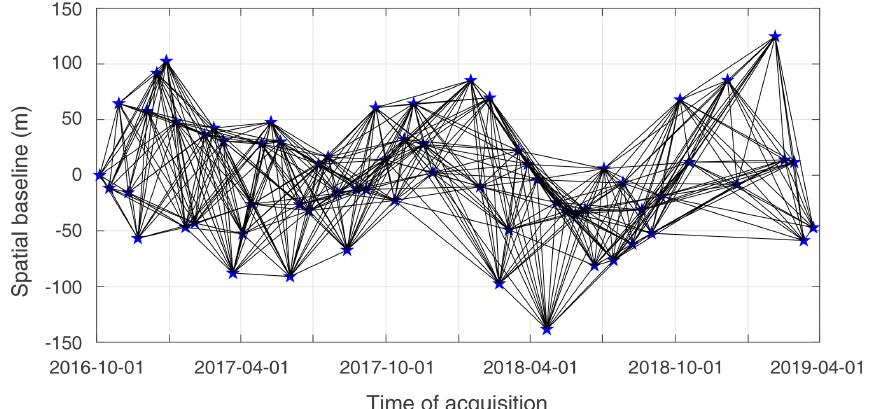
Figure 3. Spatial and temporal baselines of the interferograms.